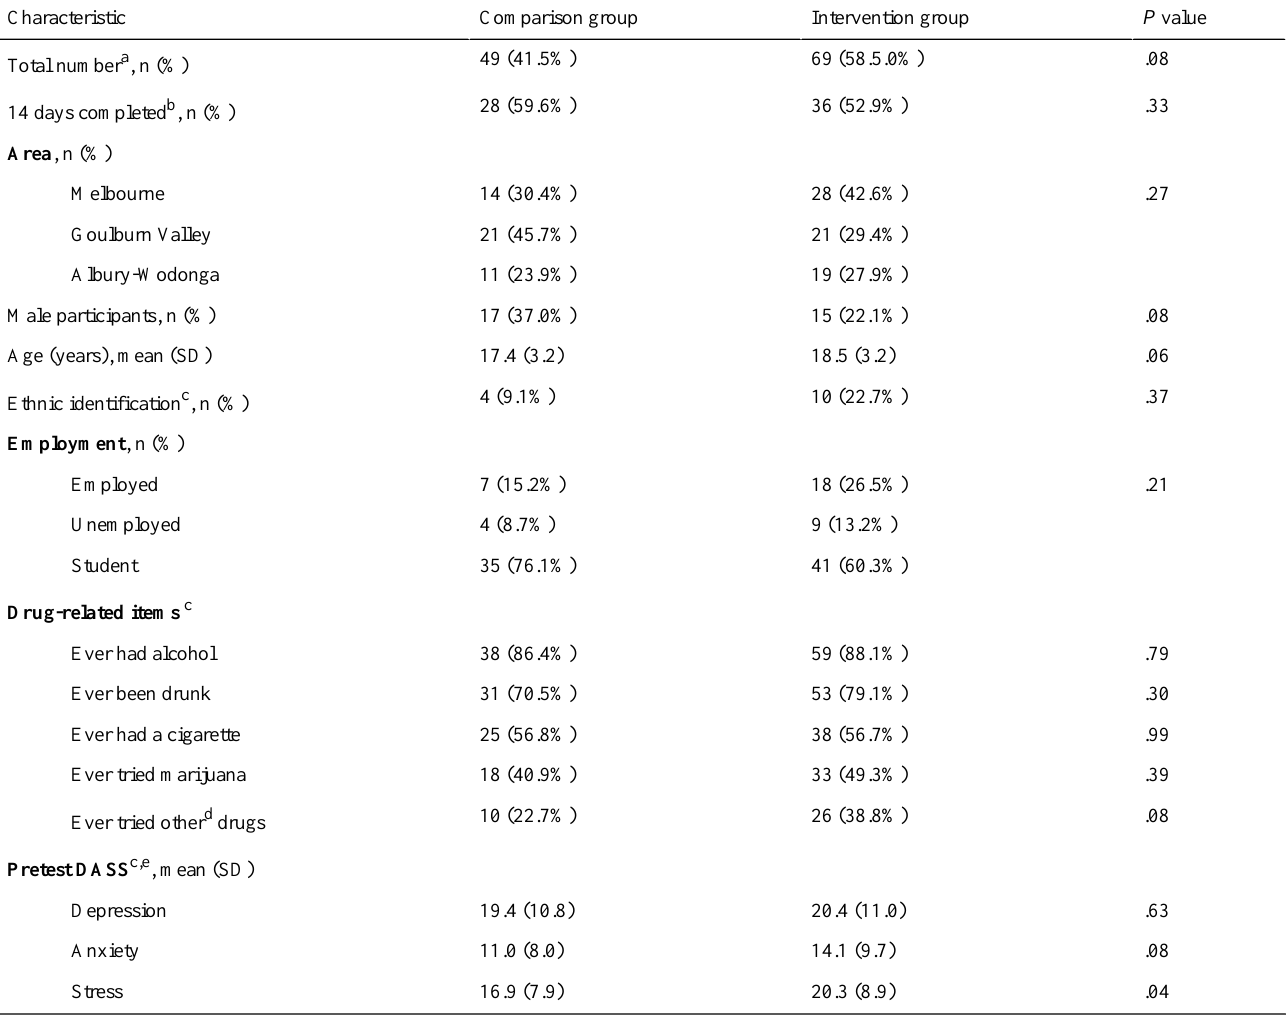
Table 2. General demographics of participants in the comparison and intervention groups (n = 114).